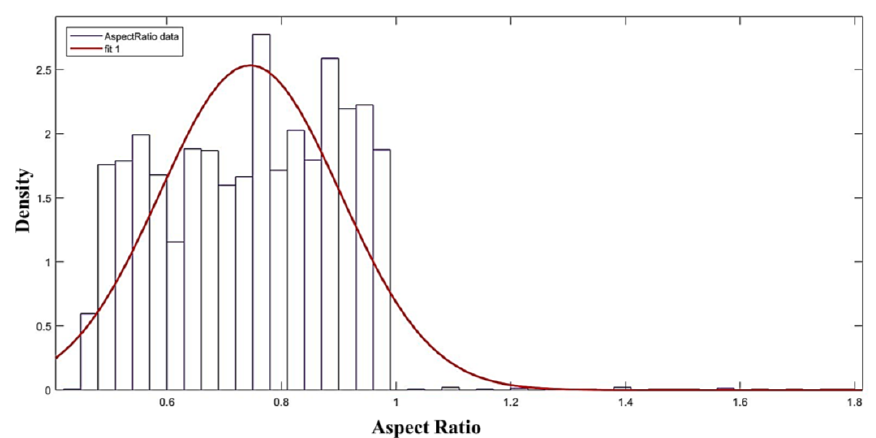
Figure A4. Density plot of pits aspect ratios ranges from (0.46–1.78).